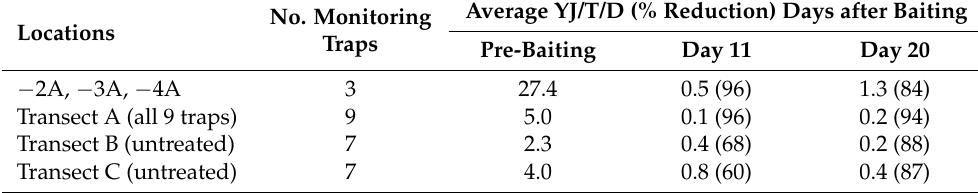
Transect B (untreated)